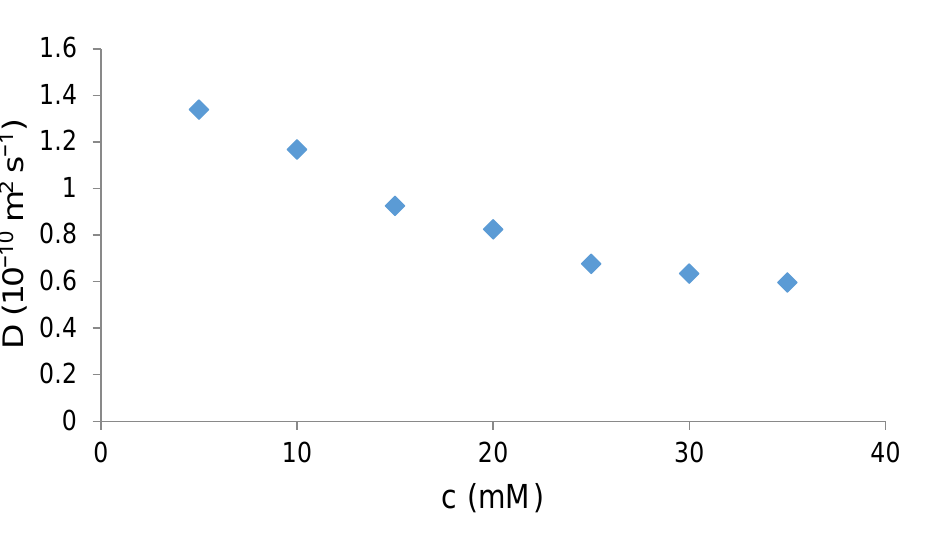
Figure 3. Diffusion coefficient of 4 versus concentration of 4 in D 2 O at 30 °C.